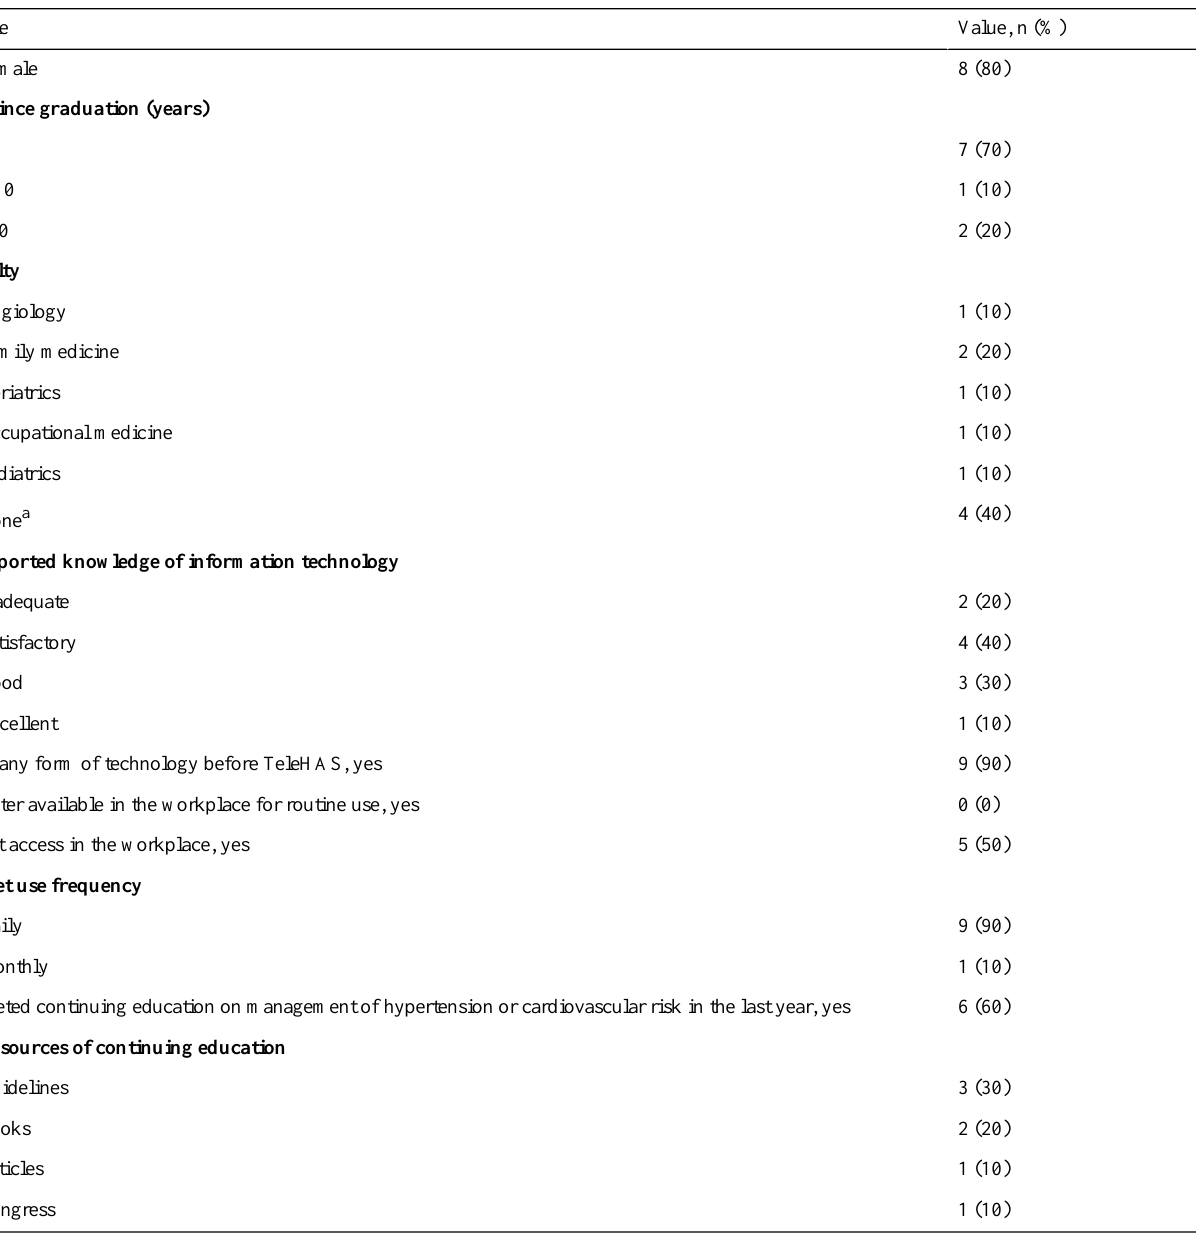
Table 2. Characteristics of primary care physicians in the study (n=10).